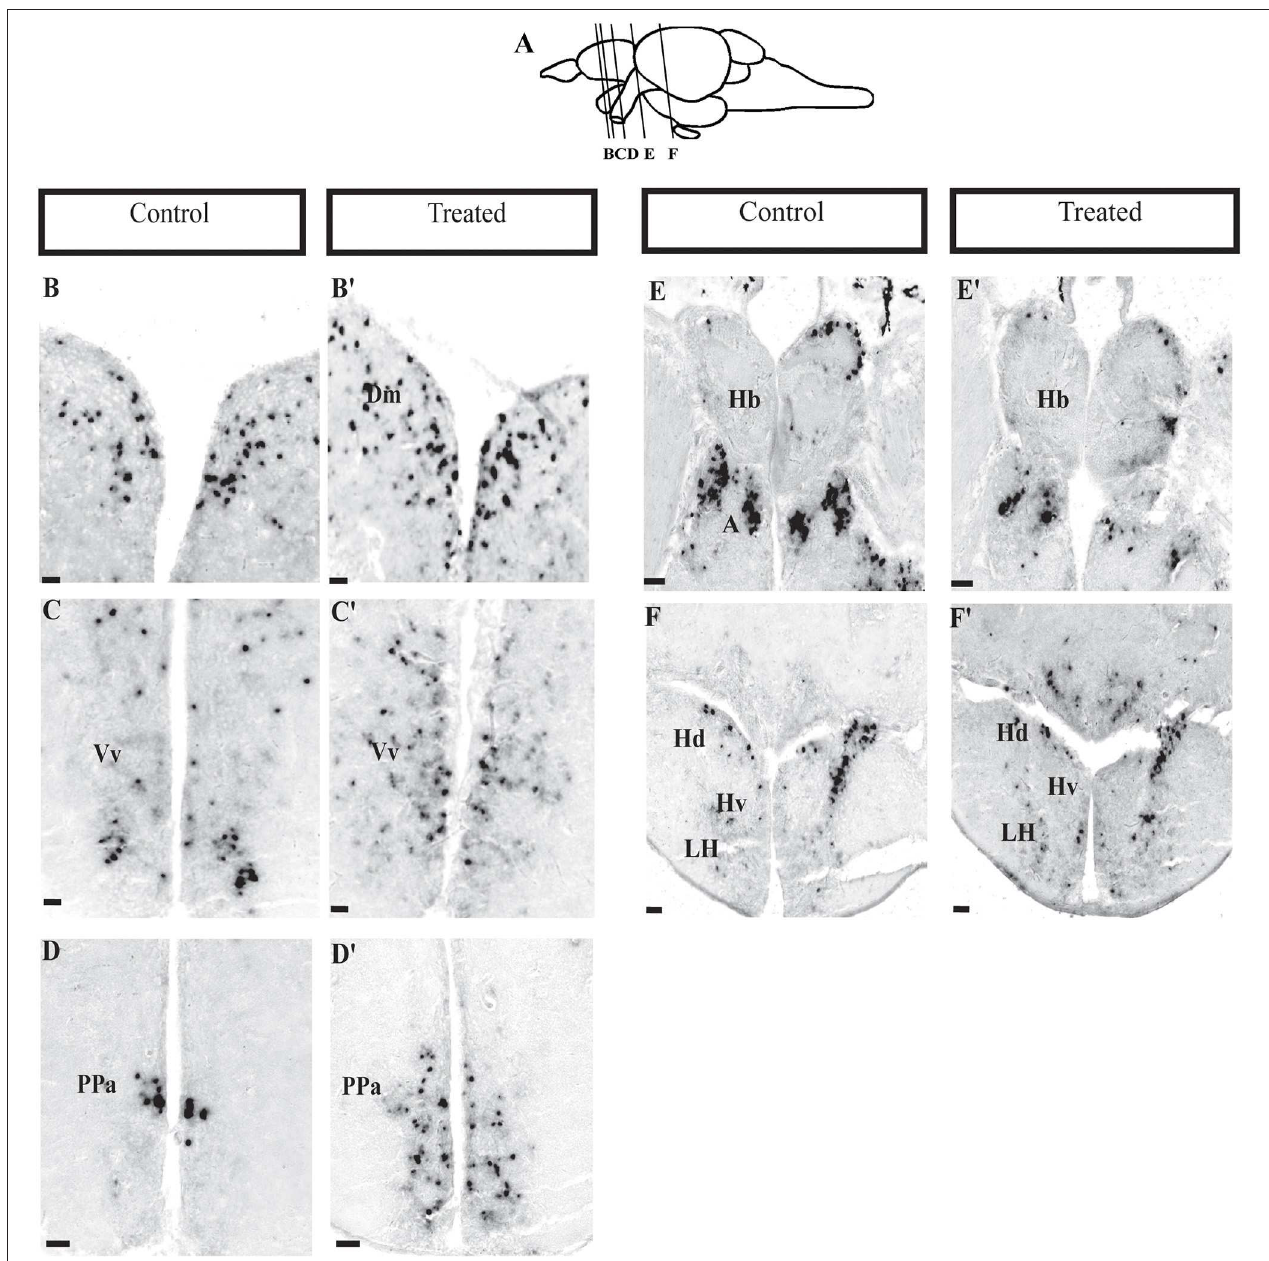
FIGURE 5 | Expression of npas4a gene in the brain of zebrafish. Photomicrographs showing the mRNA expression of neural activity marker, npas4 . (A) Lines on the schematic sagittal drawing view of the zebrafish brain indicate levels of coronal sections ( B ; control and B ′ ; morphine treated) medial zone of dorsal telencephalic area, (C,C ′ ) ventral nucleus of ventral telencephalic area, (D,D ′ ) preoptic area, (E,E ′ ) habenula, and (F,F ′ ) ventral periventricular hypothalamus. N = 6 each group. Scale bars: (B–F) and (B ′ -F ′ ) (100 µ m).